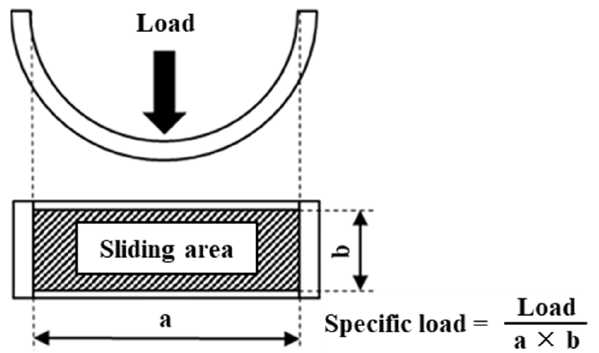
Figure 9. Method of calculating bearing specific load.